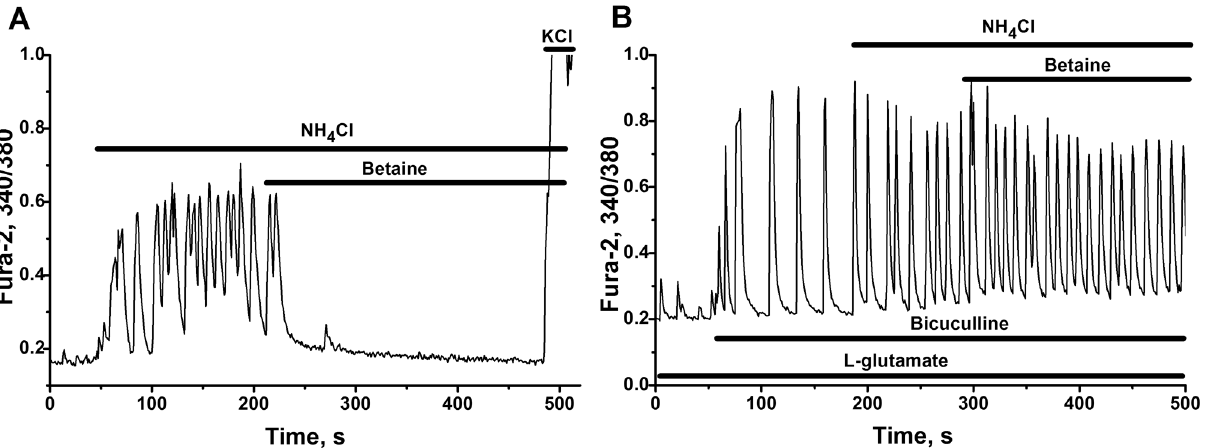
Fig 11. Inhibitory effect of betaine on the activation of networks by ammonium ions and its dependence on the operation of GABA(A)-receptors. Cultures 14 DIV. The records of representative cells. All other abbreviations and descriptions as on Fig 2. (A) Suppression of Ca 2+ -oscillations induced by 8mM NH 4 Cl after the application 10 mM of betaine. N = 136. (B ) Disappearance of suppressive effect of betaine in the presence of GABA(A)-receptors antagonist bicuculline (10 μ M). N = 124. 200 nM of L-glutamate was added before application of NH 4 Cl on Fig B.